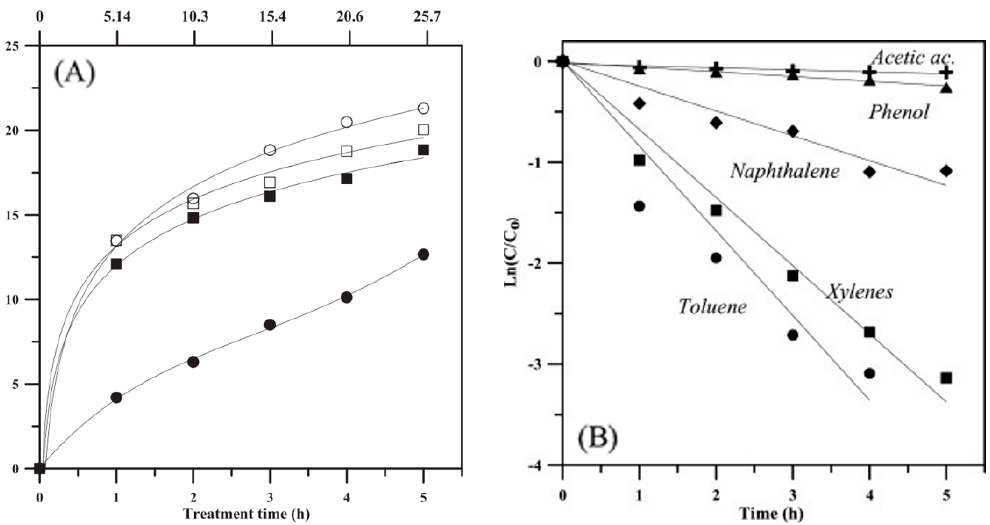
Figure 10. (A) TOC removal degree of bare TiO 2 -P25 ( ● ), bare TiO 2 -HM ( ⬛ ), rGO(10%)/TiO 2 -P25 ( ○ ); Figure 10. ( A ) TOC removal degree of bare TiO 2 -P25 ( • ), bare TiO 2 -HM ( (cid:4) ), rGO(10%)/TiO 2 -P25 ( rGO(10%)/TiO 2 -HM ( □ ) with catalyst load at 500 mg/L and (B) linear plot of TOC degradation with rGO(10%)/TiO 2 -HM ( (cid:3) ) with catalyst load at 500 mg/L and ( B ) linear plot of TOC degradation with various organic species in SPW [91]. Reproduced with permission from Elsevier, 2022. various organic species in SPW [91]. Reproduced with permission from Elsevier,